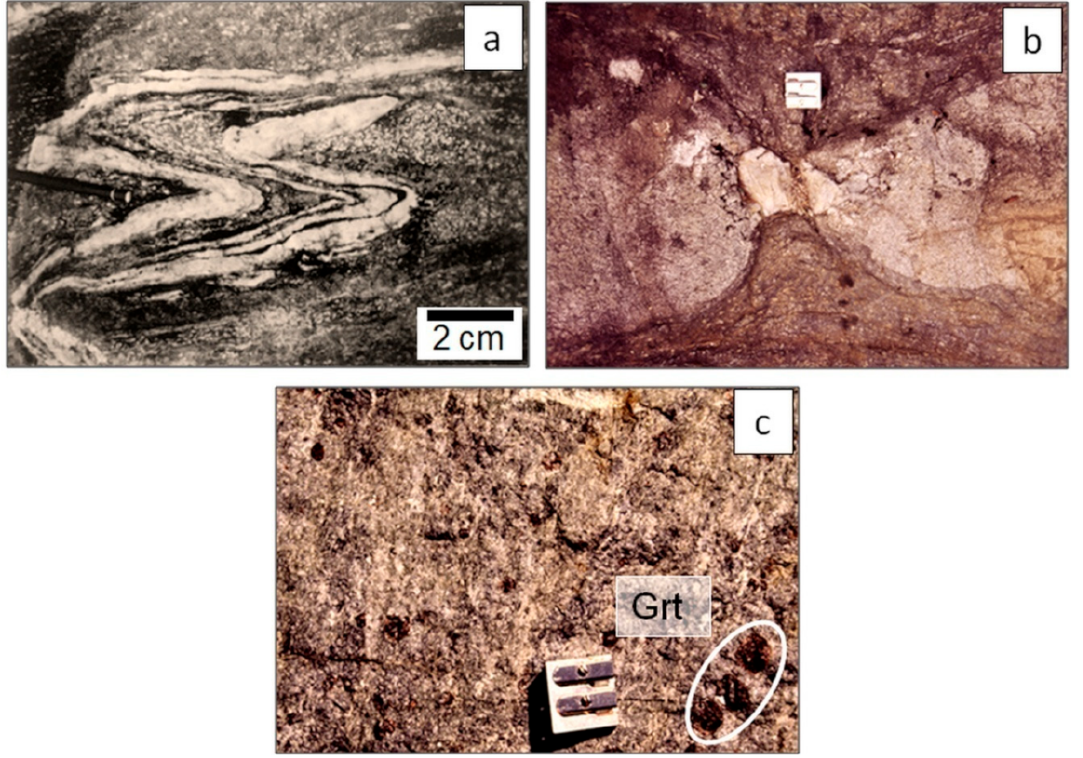
Figure 5. ( a ) Qz-rich folded veinlets, Val Seniciaga basement. ( b ) Boudinage structure in a feldspars- rich layer, Val Seniciaga basement: ( c ) Grt-bearing rock (inside the oval) at the contact with M. Ospedale, upper Val